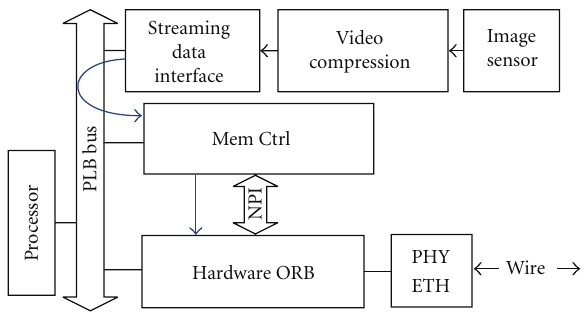
Figure 6: The usage of the hardware ORB for video streaming.